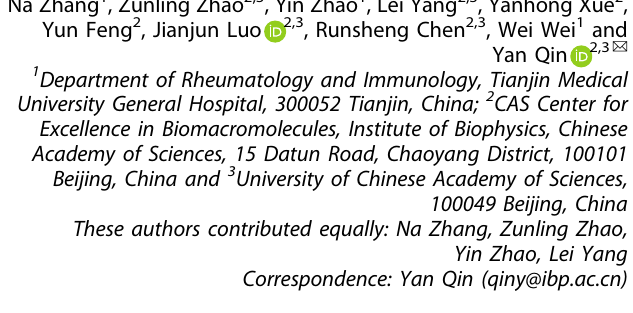
Fig. 1 Respiratory chain complex V reduction indicates cyto/mito-ribosome imbalance and their different tolerances to free radical bursts in pulmonary fi brosis. a Complex V activity of pulmonary fi brosis patients (PF) ( n = 50) and healthy controls (HCs) ( n = 9). b Complex V activity of idiopathic PF (IPF) ( n = 41), and connective tissue disease PF (CTD-PF) ( n = 9) and HCs ( n = 9). c Correlation analysis of complex V activity and serum TGF- β levels. d Receiver-operating characteristic (ROC) curve analysis of complex V activity (red)/ combined complex V activity and serum TGF- β levels (green) between PF patients ( n = 50) and HCs ( n = 9). e High-resolution computed tomography (HRCT) images at four sections of three patients with different complex V activity levels (0.10, 0.04, and 0.01). f Correlation analysis between complex V activity and HRCT score of PF patients ( n = 50). g Immunohistochemical analysis and quanti fi cation of TGF- β 1, collagen I and ATP5A1 in lung tissue of mouse model ( n = 5). h A549 cells were treated with different concentrations of TGF- β 1 for 48 hours, and images were taken using transmission electron microscope (TEM) and OMX mode of structural light illumination microscope, respectively. TEM images showed the changes of mitochondrial cristae under different experimental conditions, the images were taken using Tecnai Spirit (120 kV), scale bar = 500 nm. The OMX images showed the 3D changes of mitochondrial (green) morphology under different treatment conditions, the images were taken using SIMOMX with a ×60 oil-immersion objective, scale bar = 10 µm. i Blue native gel (BNG) and in gel activity (IGA) of mitochondrial respiratory chain complex I, complex II, complex IV, complex V of puri fi ed mitochondria. j Immunoblot for protein expression levels of NDUFA9, SDHA, UQCRC2, ATP5A1, and TOM20 in HLF cells lysates with different treatment conditions. All lanes were loaded with the same amount of total protein. k Quanti fi cation of ATP5A1 in ACEII cells with TGF- β 1 treatments. l Annotation of transcripts of differential expression of genes in A549 cells induced by TGF- β 1 at 0 and 10 ng/ml in KEGG database ( n = 3). m The polysome difference between the 10 ng/ml treatment group and the 0 ng/ml control group. n , r The expression of RPS6 ( n ) and MRPL48 ( r ) in cells was detected by immunohistochemistry. The images were taken using Nikon STED with a ×100 oil-immersion objective under the same parameter settings, scale bar = 10 μ m, zoomed in: scale bar = 200 nm. o , s Fold changes of RPS6 ( o , n = 3) and MRPL48 ( s , n = 15) expression in A549 cells induced by TGF- β 1, the mean fl uorescence intensity was obtained by Image J for statistics. p , q Fold changes of total RNA detected by agarose gel electrophoresis in A549 cells induced by TGF- β 1, statistics were made by the grayscale value of electrophoretic band strips measured by Image J. t , u Fluorescence quantitative PCR analysis of mitochondrial 16 S and 12 S ( n = 3). v , w L-AHA (a homolog of L-Met) detection of the ribosome translational function of living cells and mitochondria, statistics were made by the grayscale value of western blot strips measured by Image J ( n = 3). x Respiratory chain complex V reduction indicates cyto-/mito-translation imbalance and different tolerances to free radical burst in pulmonary fi brosis. One-way ANOVA with Tukey ’ s multiple comparisons test and student t test were performed. * P < 0.05; ** P < 0.01; *** P < 0.001; **** P <